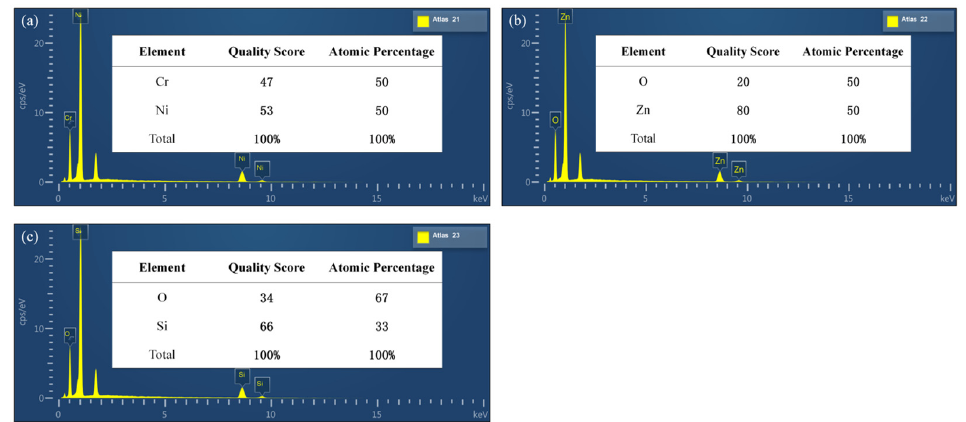
Figure 8. ( a ) Energy spectrum analysis of NiCr electrode film, ( b ) energy spectrum analysis of ZnO piezoelectric thin film, and ( c ) energy spectrum analysis of SiO 2 insulating film.